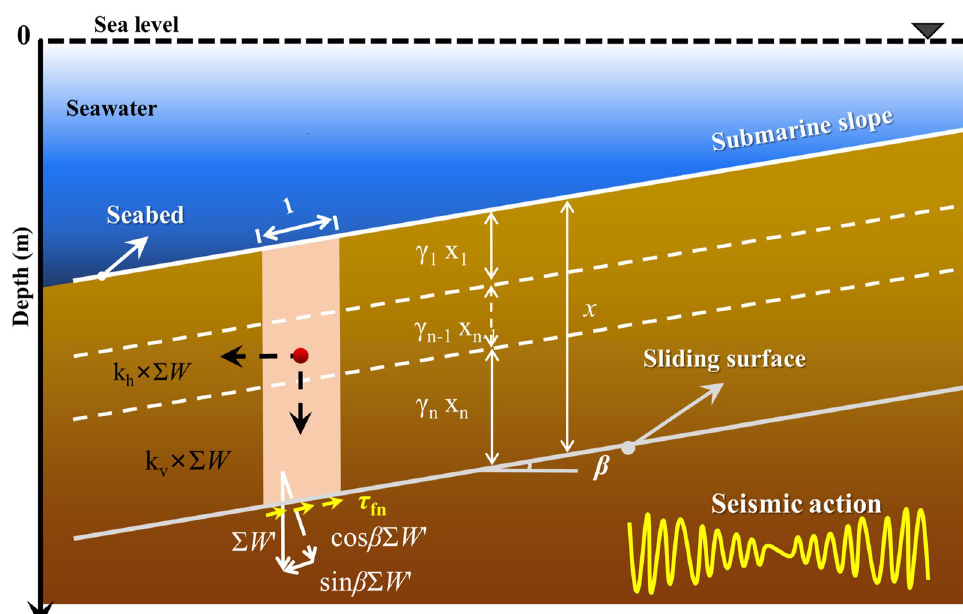
Fig. 20 Stress analysis of a submarine slope under seismic loading (modified from Nian et al.